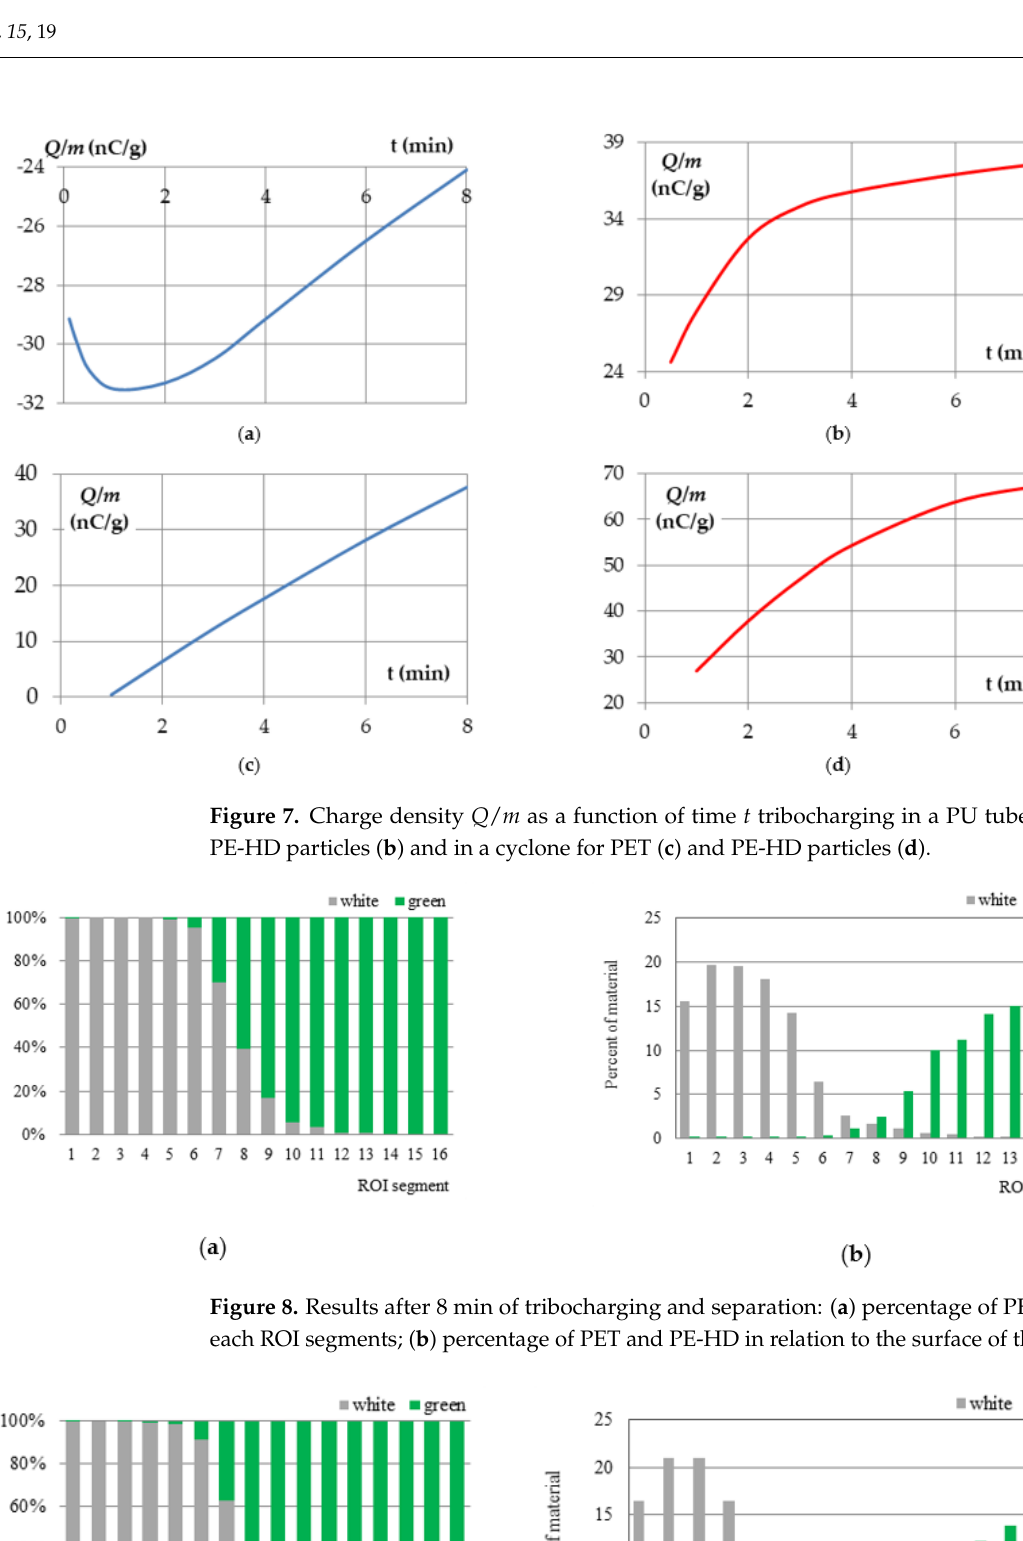
Figure 8. Results after 8 min of tribocharging and separation: ( a ) percentage of PET and PE-HD in each ROI segments; ( b ) percentage of PET and PE-HD in relation to the surface of the ROI seg- ments.